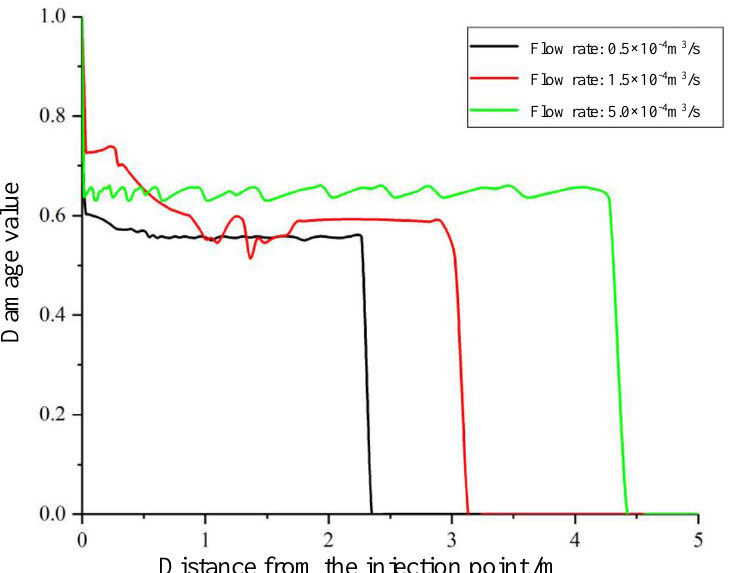
ff ect of flow rate of fracturing fluid on the crack Figure 22. The effect of flow rate of fracturing fluid on the crack propagation. Figure 22. The e